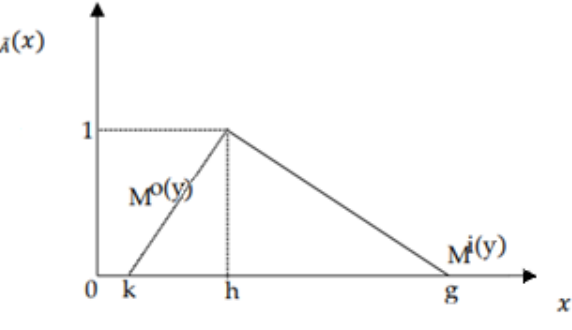
Figure 3. Triangular fuzzy number.